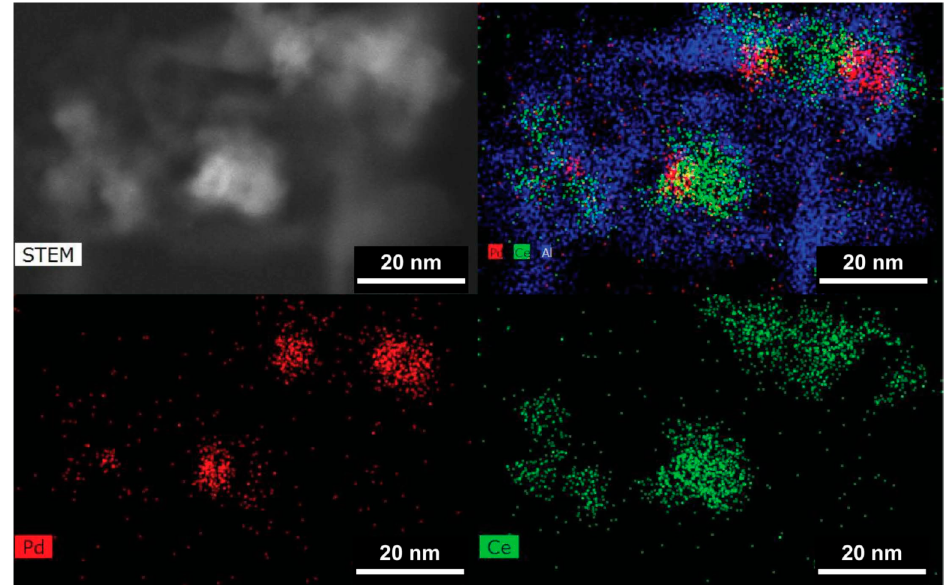
Figure 6. HAADF-STEM image and EDS mapping of 20CeO 2 -4Pd/Al 2 O ₃ catalyst. ( top left ) STEM image; ( top right ) elementary distribution of Pd, Ce, Al overlapped together; ( bottom left ) EDS mapping to show elementary distribution of Pd; ( bottom right ) EDS mapping to show elementary distribution of Ce. Pd, Ce, and Al are color coded as red, green, and blue, respectively.